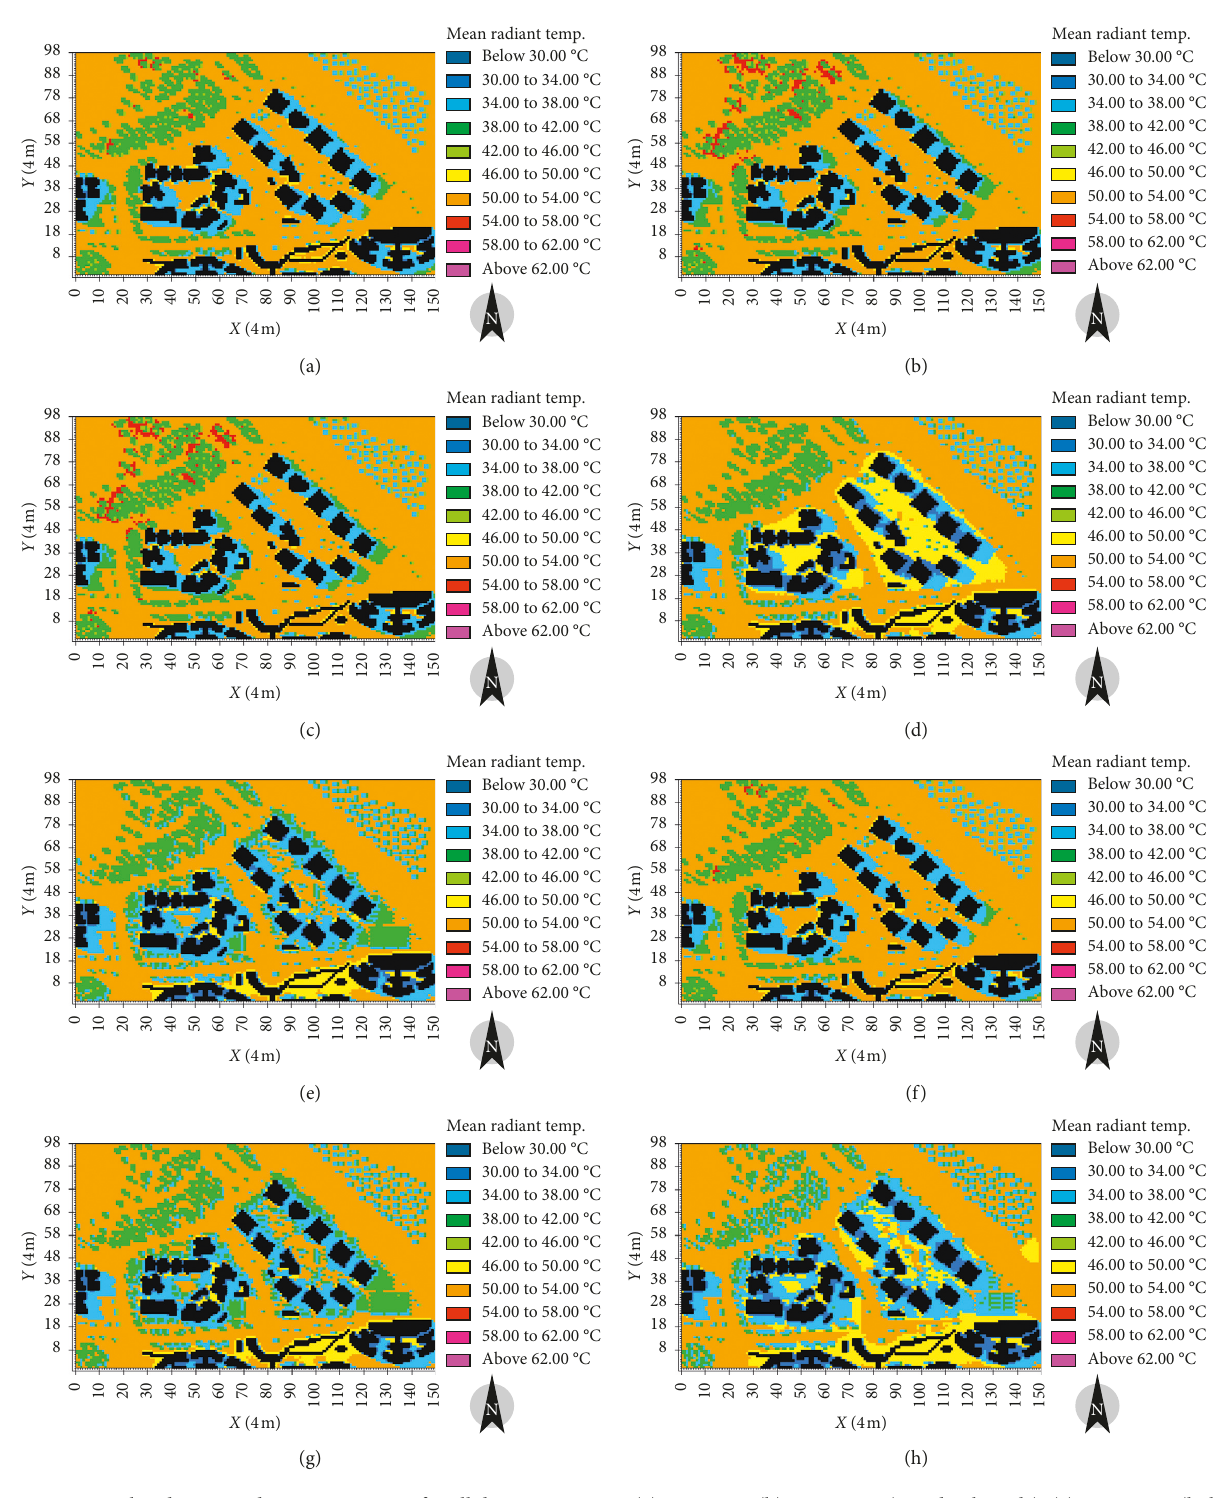
Figure 8: Simulated mean radiant temperature for all design scenarios. (a) Base case. (b) Scenario 1 (wooden boards). (c) Scenario 2 (light- color granite). (d) Scenario 3 (grass surface). (e) Scenario 4 (more trees). (f) Scenario 5 (more water bodies). (g) Scenario 6 (light-color granite +more trees). (h) Scenario 7 (grass surface+more